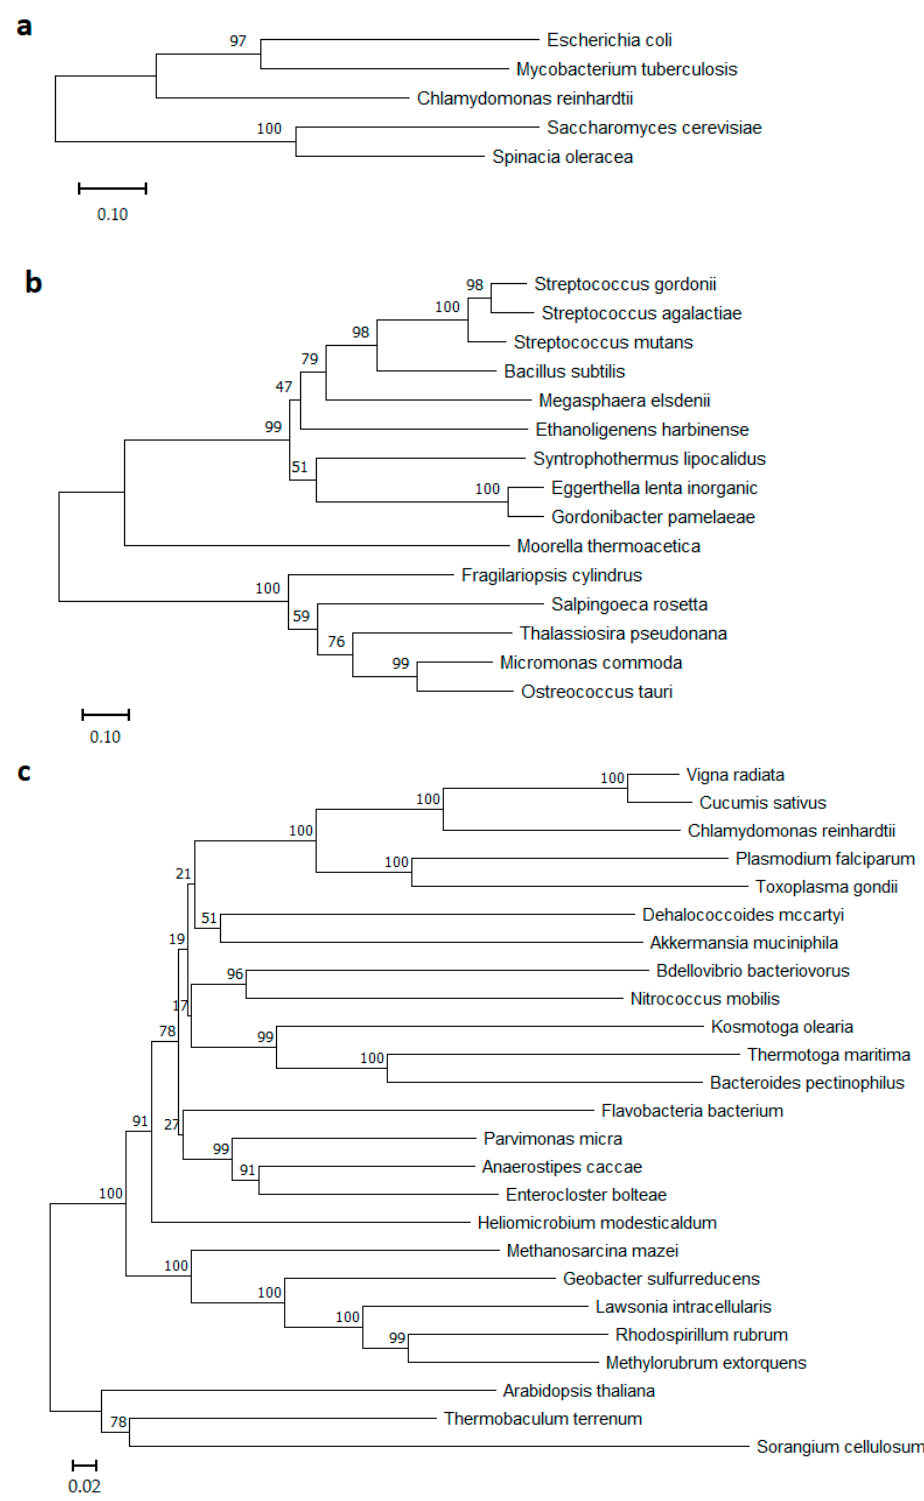
Figure 1. Phylogenetic trees of ( a ) soluble PPases Family I, ( b ) soluble PPases Family II, and ( c ) membrane-bound PPases protein sequences. Phylograms were generated using NJ